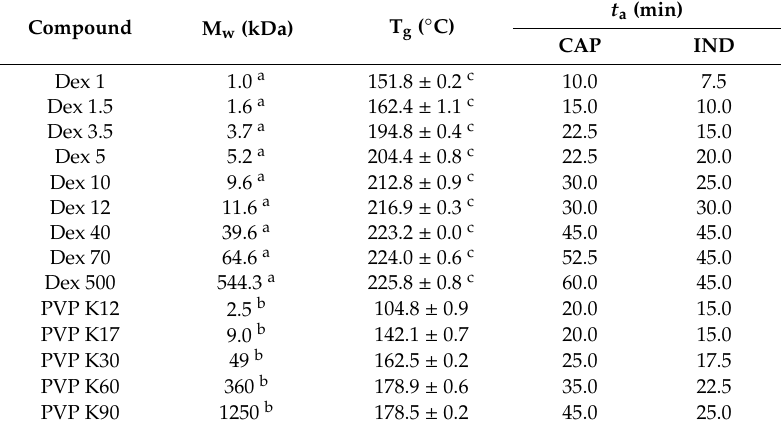
Table 1. The polymer molecular weight (M w ) and corresponding glass-transition temperature (T g ) for dextrans (Dex) and polyvinylpyrrolidone (PVP) and their influence on the ball milling time to reach full drug amorphization ( t a ) for both chloramphenicol (CAP) and indomethacin (IND). Compound